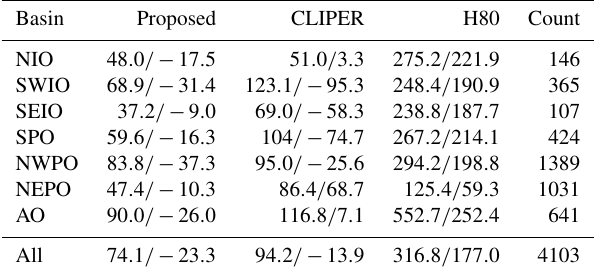
Table 4. Root-mean-square difference (RMSD; first number) and bias (second number) for (cid:49) AR35 in kilometers for the validation period for the proposed relationships, CLIPER (Knaff et al., 2015) and the H80 wind profile.